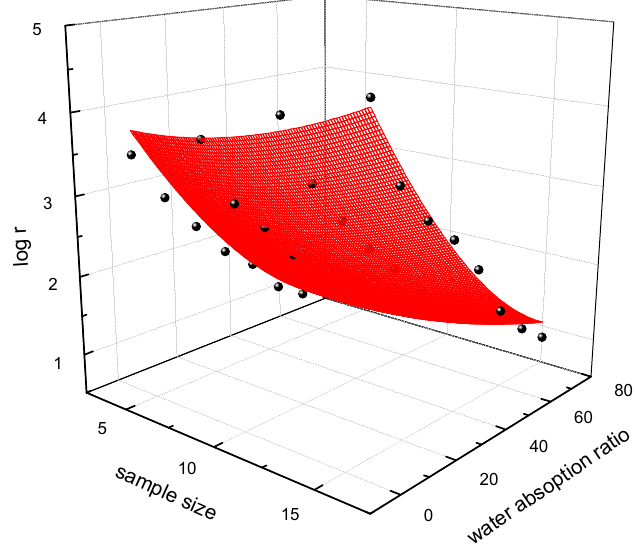
Figure 11. The plot of the predicted mode of electrical resistance.